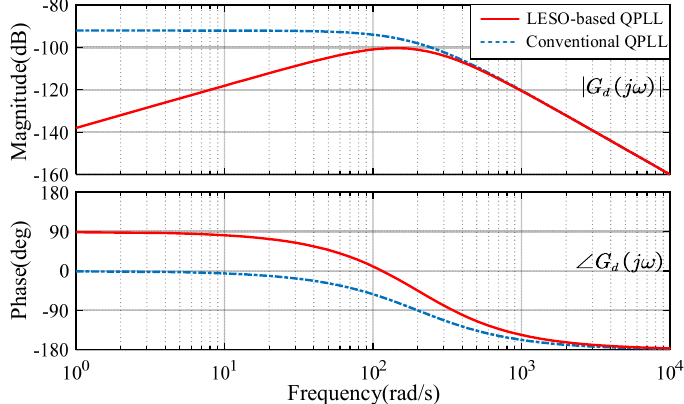
Figure 4. Bode diagram of the transfer function G d _QPLL ( s ) and G d _LESO ( s ) ( σ = 200